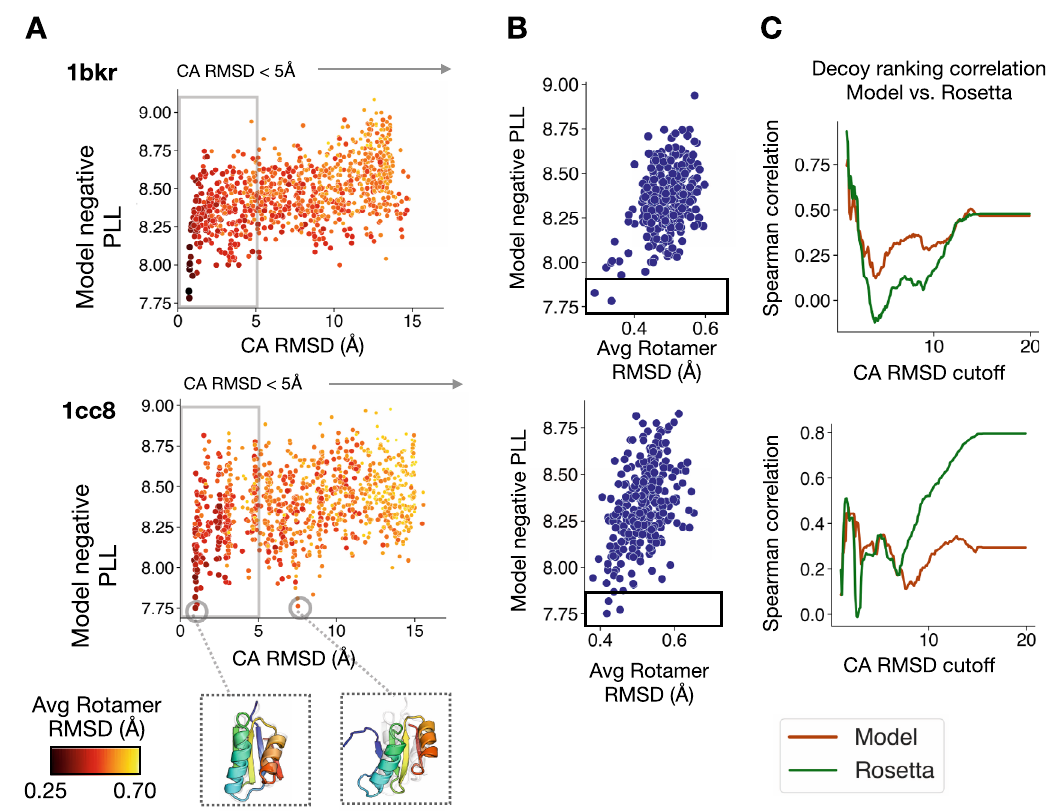
Fig. 3 Model captures sequence – structure relationship. A , B Decoy ranking by model negative pseudo-log-likelihood (PLL) of the native sequence. A Model negative PLL vs. alpha-carbon RMSD (Å) to the native structure for Rosetta ab initio decoys. Points are colored by average side-chain RMSD to native (Å). In some cases, the model assigns low negative PLL to high RMS backbones; for example, for 1cc8 an alternative pattern of beta-strand pairing is shown (Inset). B Model negative PLL of low backbone RMS structures (CA RMSD < 5 Å) vs. average side-chain RMSD (Å). Box highlights low model negative PLL assigned to low side-chain RMSD decoys. C Spearman rank correlation between model negative PLL or Rosetta energy vs. structure alpha- carbon RMSD (Å) as a function of increasing RMSD cutoff. In the low RMS regime (<5 Å), the model and Rosetta are able to rank low RMS structures to a similar